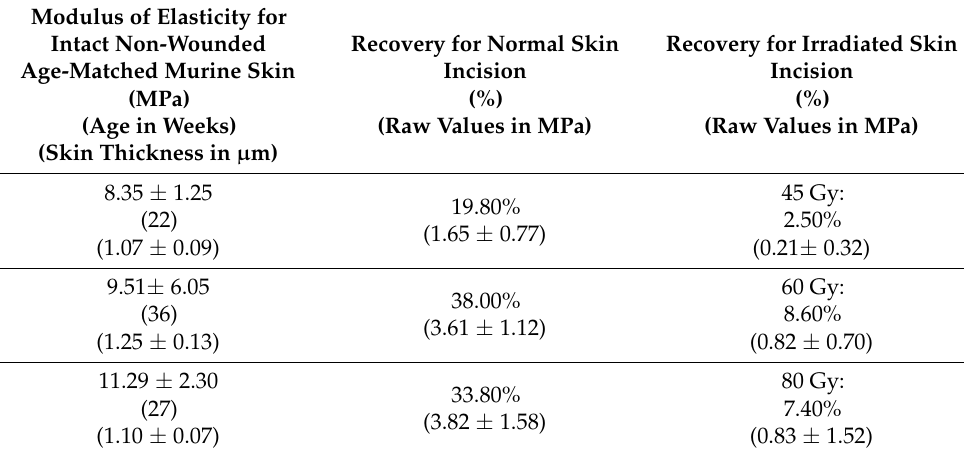
Table 4. Modulus of elasticity values for intact non-wounded skin compared with normal and irradiated skin